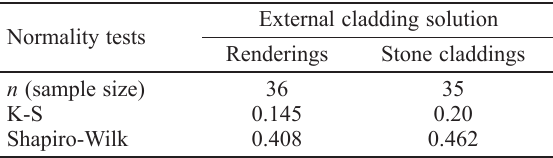
table 4. results of the normality tests of the samples used in this study for the artificial neural networks method Normality